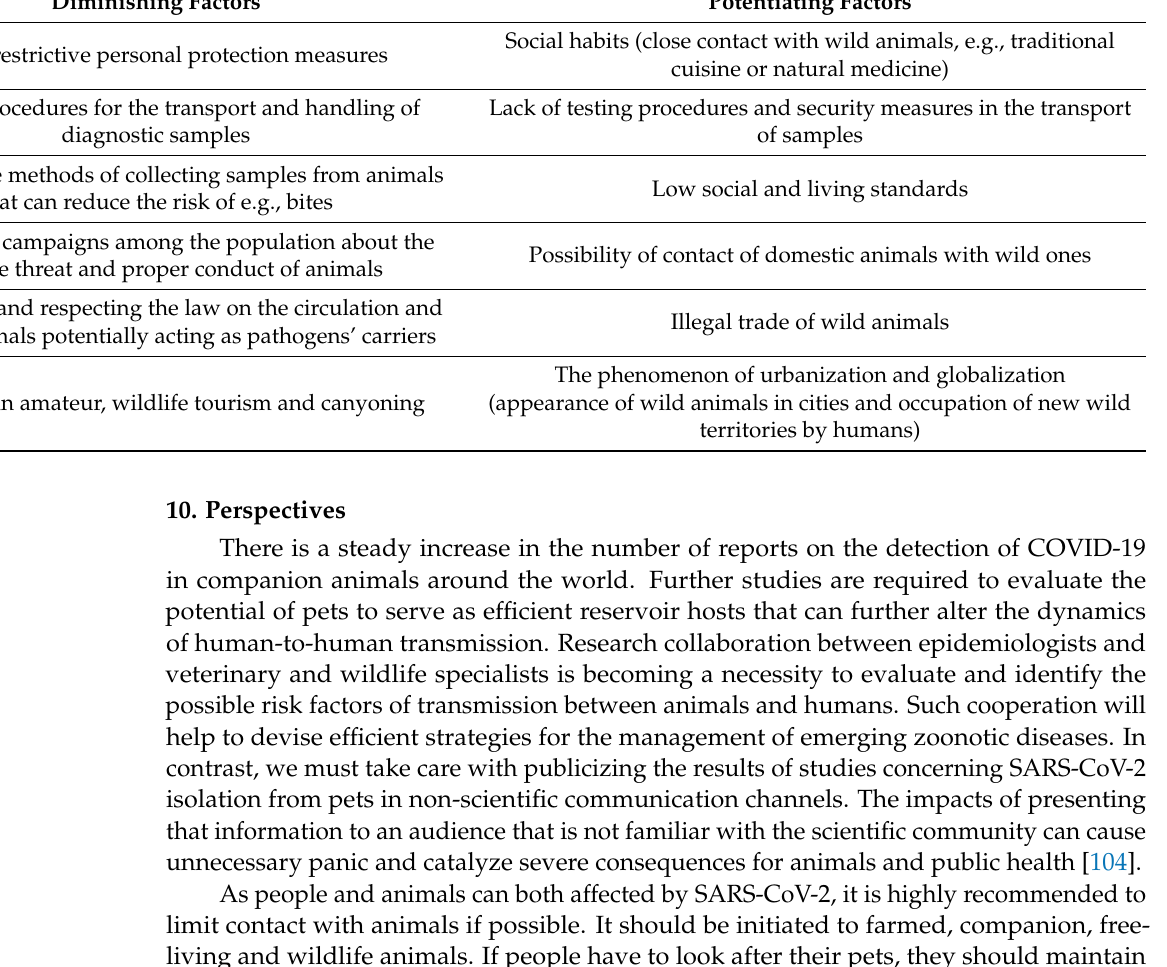
Table 3. Factors influencing the potential risk of transmission of SARS CoV-2 from animals to humans. The Potential Risk of SARS CoV-2 Transmission Diminishing Factors Potentiating